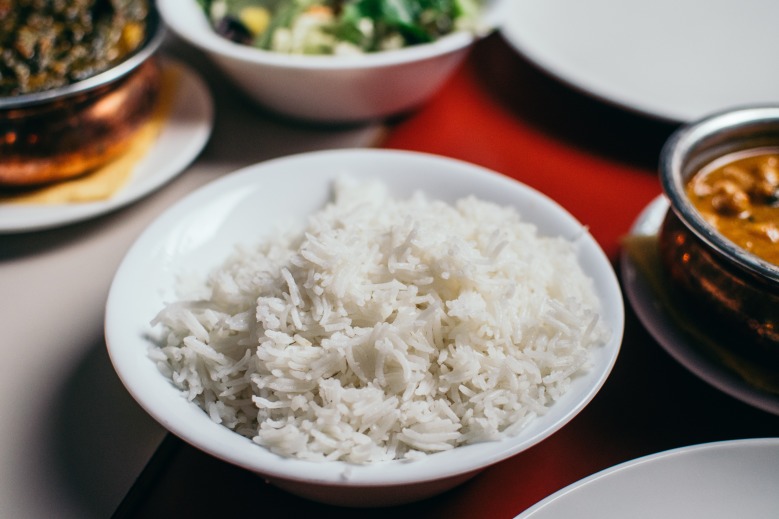
Photo: Rice is the main dish in South Asia. The image is downloaded from unsplash.com, originally contributed by Pille-Riin Priske, @pillepriske.